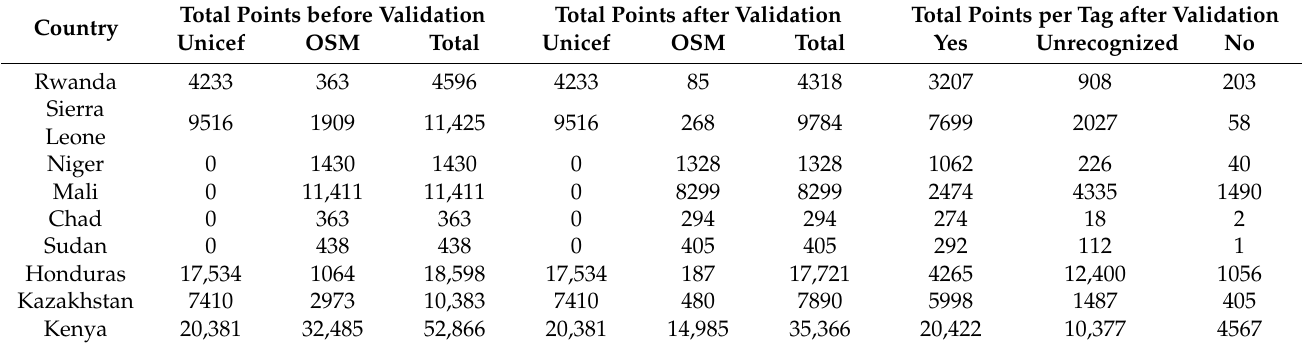
Table 1. School data sources for this study from UNICEF Office of Innovation and OpenStreetMap (OSM). Before and after training dataset